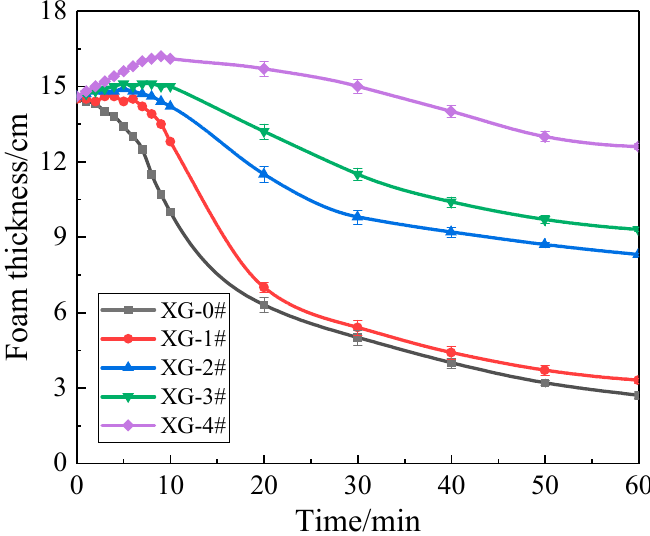
Figure 5. Variation in foam thickness under 200 °C versus time.